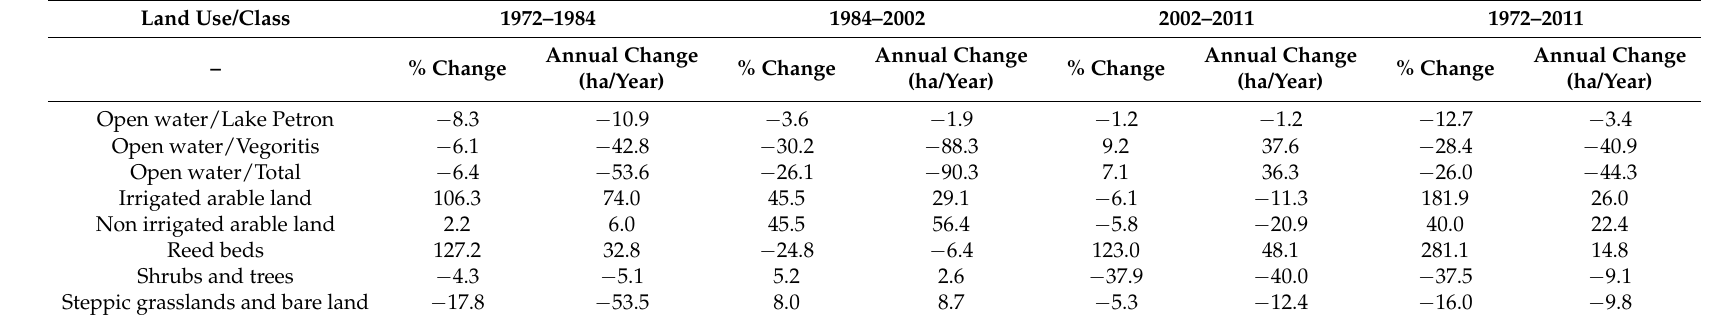
Table 5. Changes (%) of the land cover/land use classes and annual rate of change for the studied